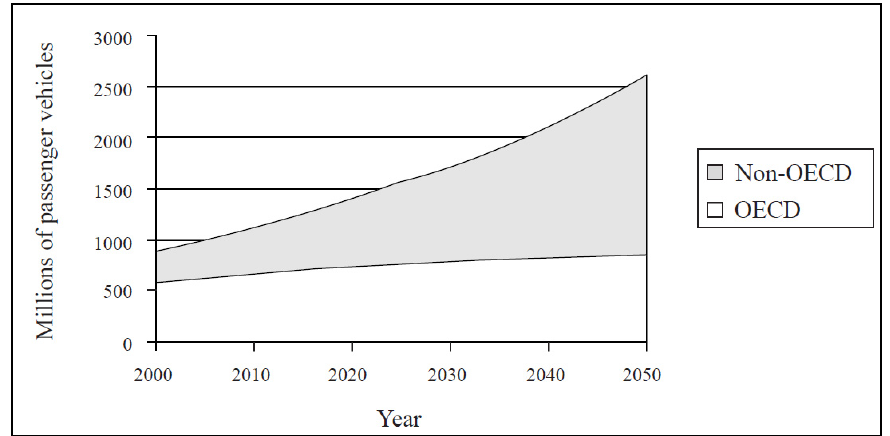
Figure 2. Vehicle ownership by region. Source: Wright and Fulton [26].